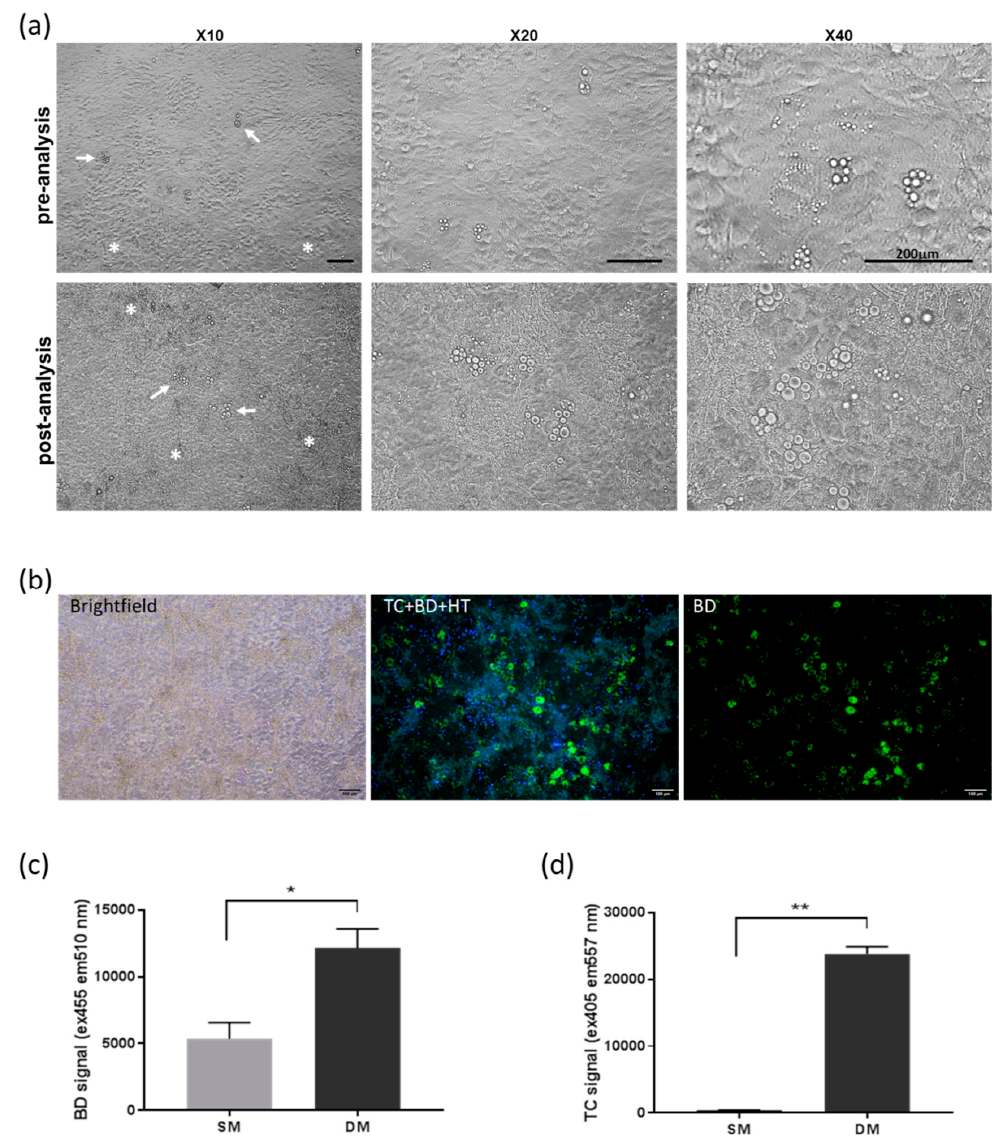
Figure 3. MSC cultures observed before and after TC / BD / HT labelling. ( a ) Brightfield images of di ff erentiated MSCs before (day 10) and after (day 23) undergoing live labelling and imaging steps, confirming maintained di ff erentiation phenotypes as indicated by mineral deposits (asterisks) and adipocytes (arrows). Scale bar = 200 µ m ( b ) Fluorescence imaging of live cultures repeated at the endpoint, confirming sustained di ff erentiation 6 days after the initial labelling and imaging carried out at day 19. Scale bar = 100 µ m. ( c , d ) Corresponding signal quantification using a plate-reader showing increased BD and TC signal in DM conditions (* p < 0.05, ** p < 0.005). Confocal z -stack images were taken at the endpoint to better observe the close association of the mixed phenotypes obtained in differentiated MSC cultures (Figure 4). These revealed lipid-filled adipocytes, marked by strong cytoplasmic BD signal, interspersed and embedded in the TC-labelled mineralised matrix.